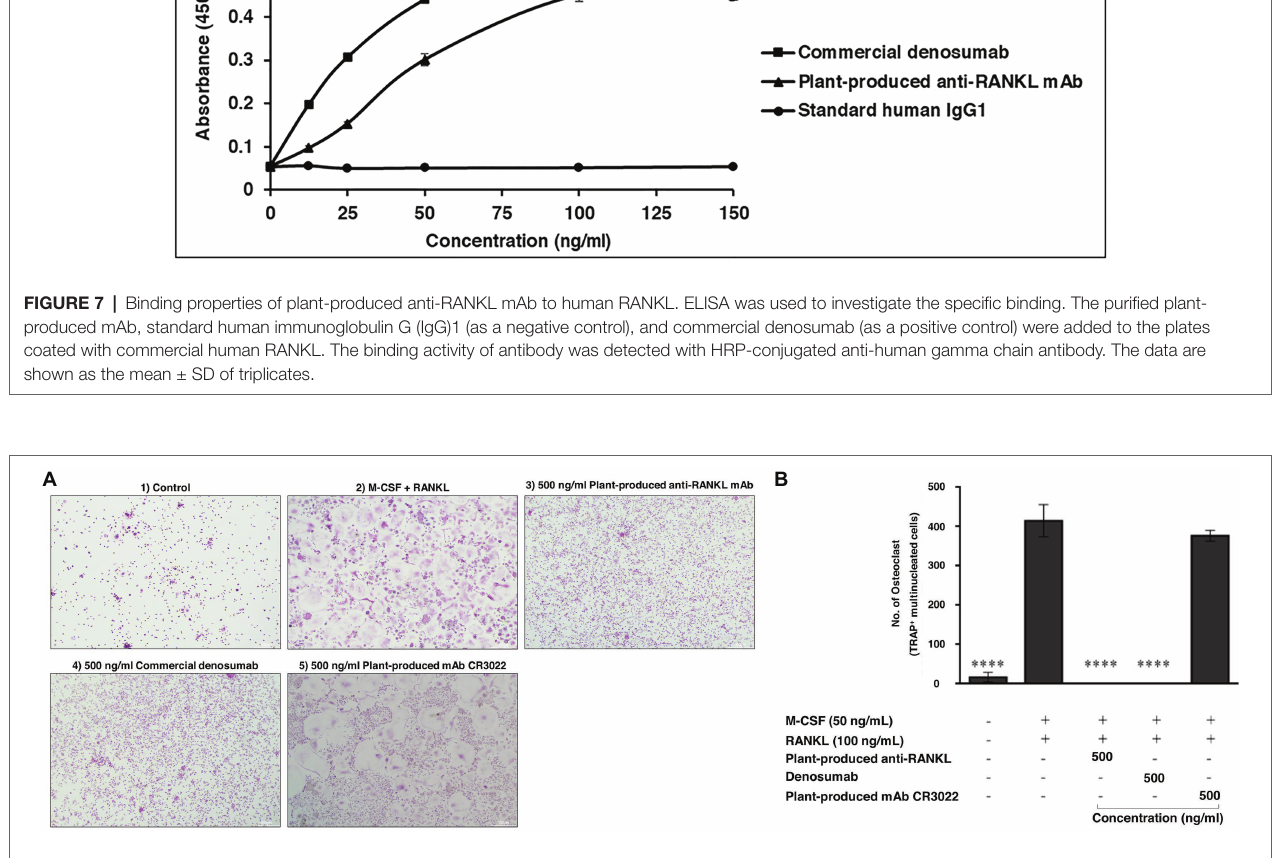
FIGURE 8 | Plant-produced anti-RANKL mAb suppresses osteoclast differentiation. CD14 + monocytes were cultured under different conditions for 15 days following (1) control, (2) M-CSF and RANKL, (3) 500 ng/ml plant-produced anti-RANKL mAb, (4) 500 ng/ml commercial denosumab, and (5) 500 ng/ml plant- produced mAb CR3022. (A) Representative images of TRAP staining. (B) Quantification of TRAP + osteoclasts is shown as the mean and SEM of triplicate ∗∗∗∗ p ≤